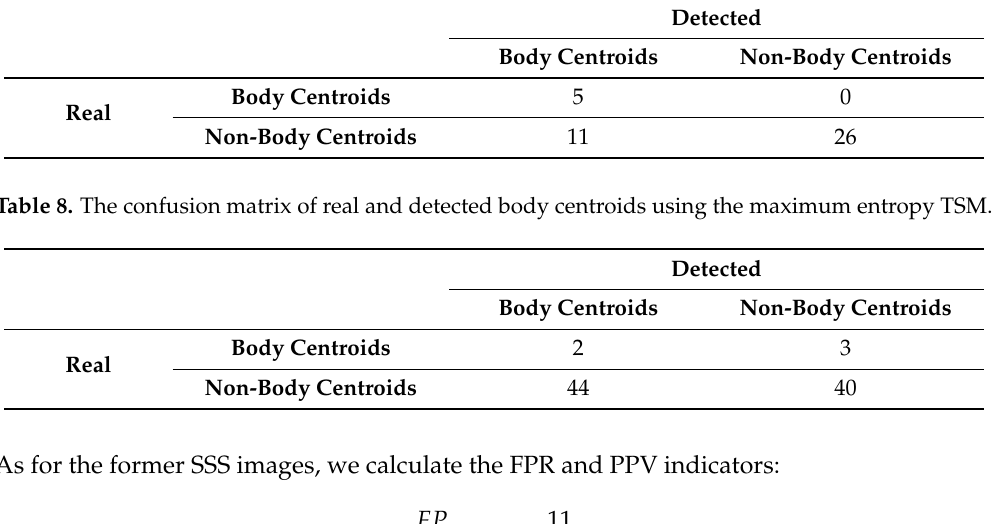
Table 7. The confusion matrix of real and detected body centroids using the improved Otsu TSM.